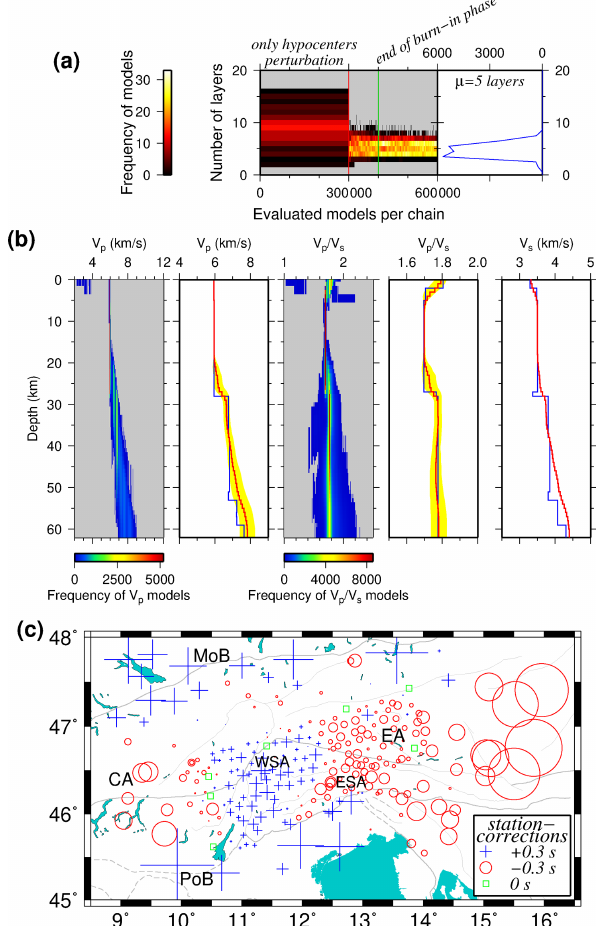
Figure 9. (a) On the left histogram, the probability of the number of layers of the random models introduced by Markov chains during the evolution are shown (color indicates number of models). On the right histogram, the number of layers of the models after burn-in phase is given. (b) V P , V P /V S , and V S models after McMC simul- taneous inversion. Figure characteristics are similar to Fig. 7. The velocity models are recovered down to ∼ 63km depth. (c) P wave station corrections of all the stations that were involved in the inver- sion corresponding to the 1-D velocity model in (b) . Negative cor- rections (red circles) indicate earlier arrivals (indicative for higher velocities in the shallow subsurface) and positive corrections (blue crosses) indicate delayed arrivals (representative for lower veloci- ties underneath the station). The faults are same as in Fig. 2. Abbre- viations are as follows: CA stands for central Alps, EA stands for eastern Alps, ESA stands for eastern southern Alps, WSA stands for Western Southern Alps, MoB stands for Molasse Basin, and PoB stands for Po